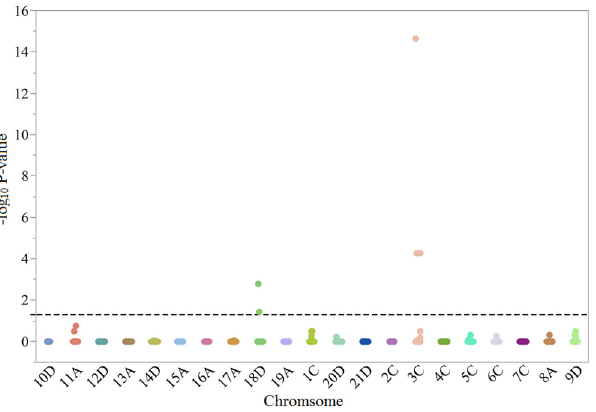
Fig 1. Genome-wide association for oat BYDV tolerance. The dotted line represents the significance threshold at α = 0.05 (-log 10 (p-value) (cid:4) 1.30), for false discovery rate adjusted